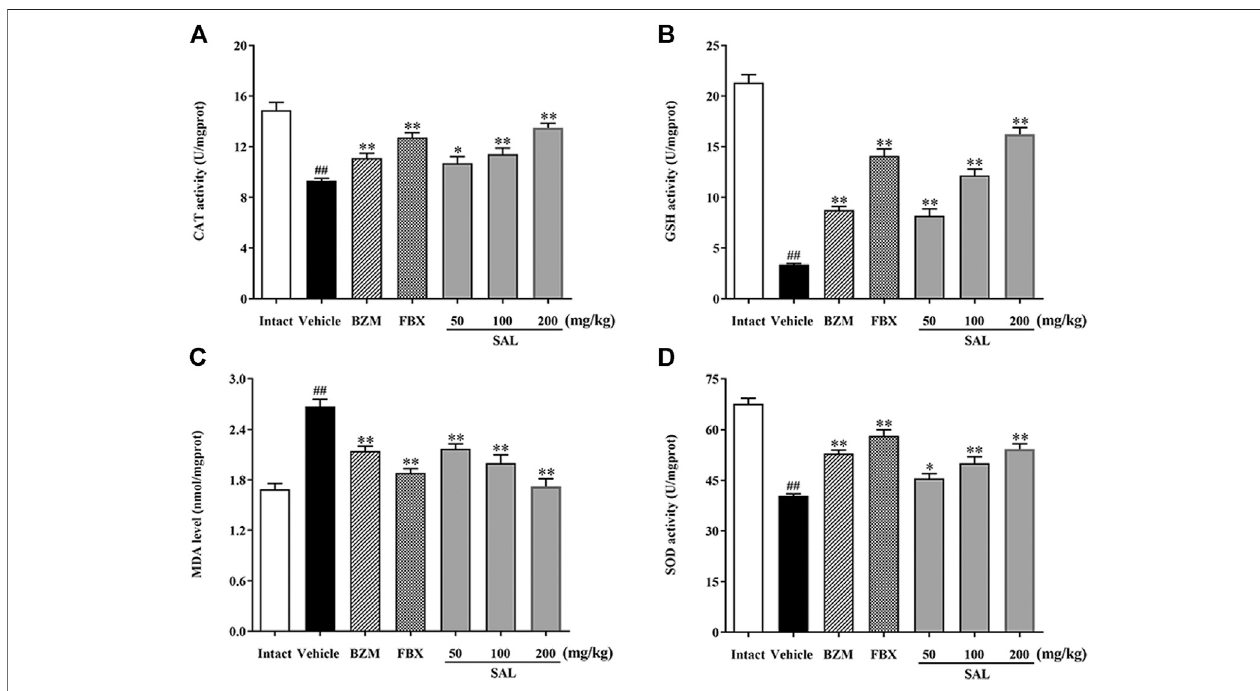
FIGURE 5 | Activity of antioxidant enzymes. (A) CAT; (B) GSH; (C) MDA; (D) SOD. All data are expressed as mean ± SD ( n (cid:2) 8). ## p < 0.01 vs. the intact group, *p < 0.05, **p < 0.01 vs. the vehicle group.